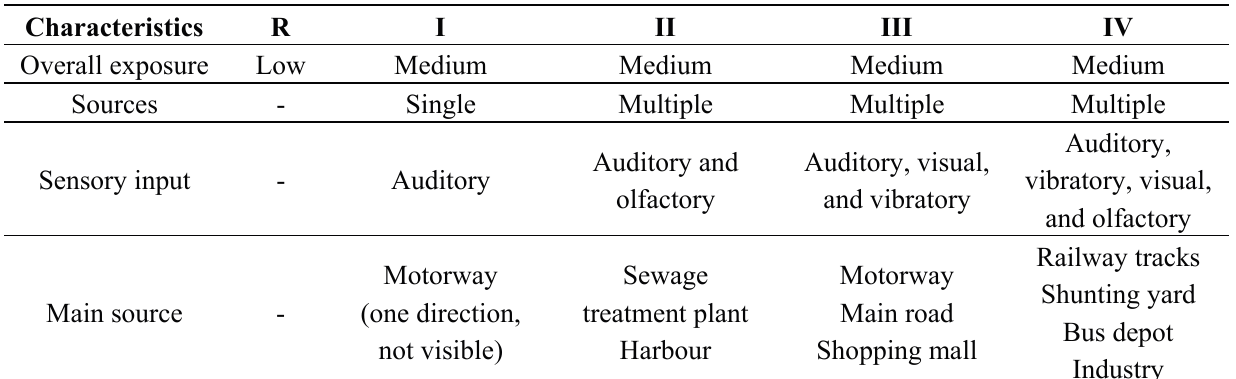
Table 1. Characteristics of the study areas; all areas were exposed to low intensity local